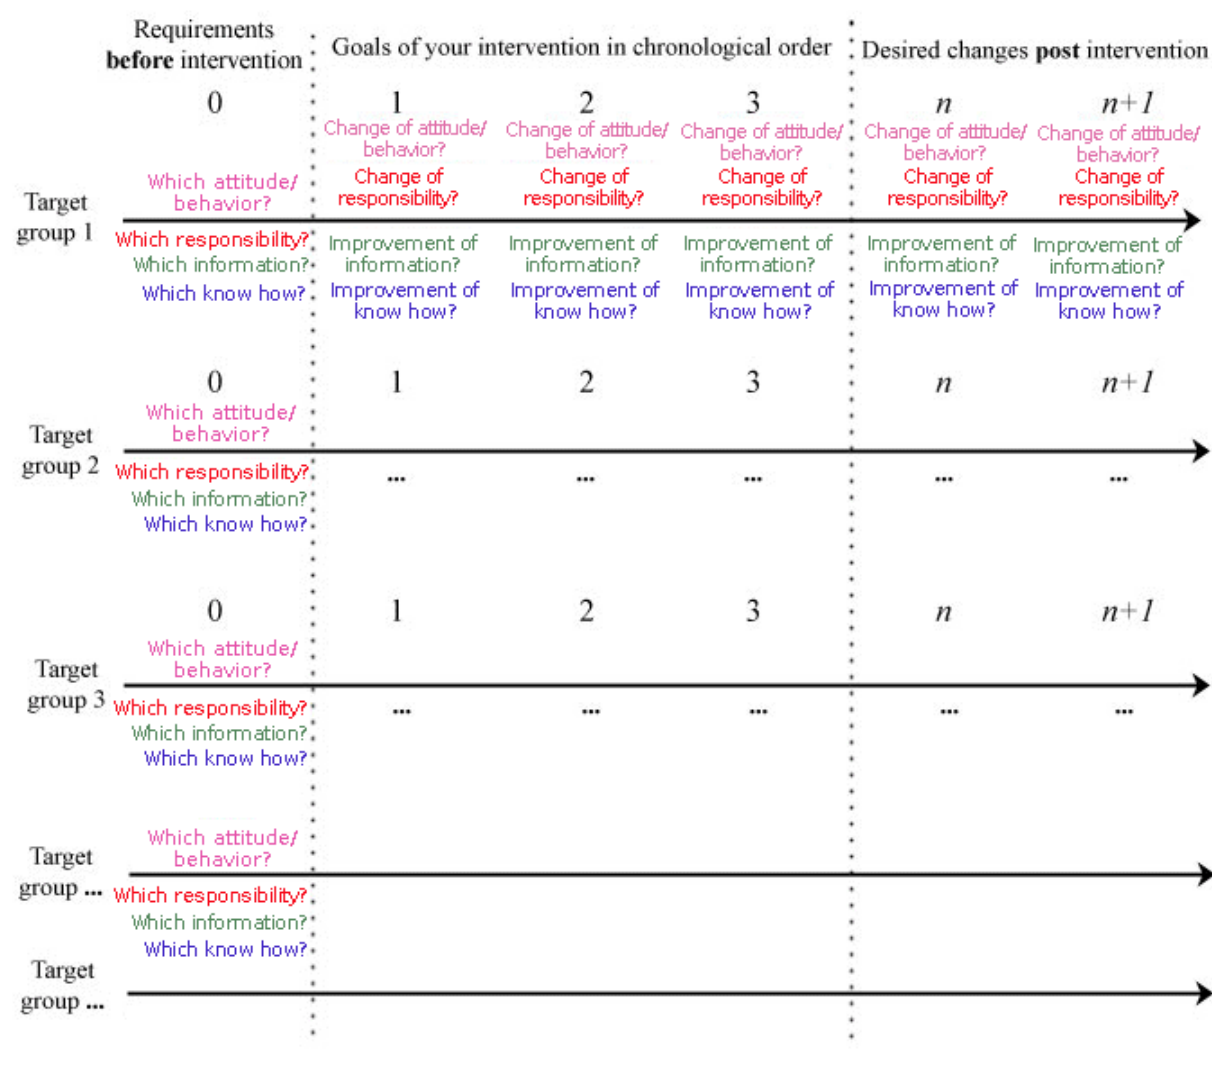
Fig. 3. Example: Matching potential stakeholders to process